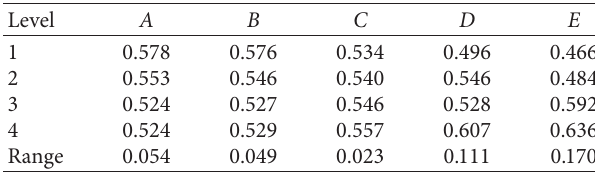
Table 8: Range analysis of the grey correlation